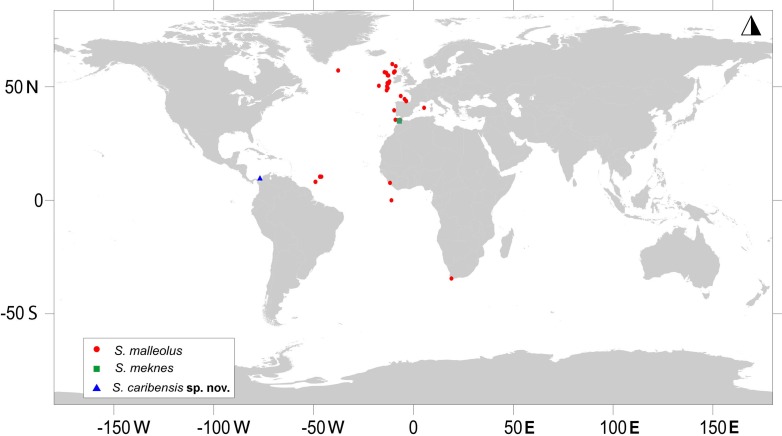
Map showing the worldwide distribution of Sphyrapus.Sphyrapus malleolus (red circles), Sphyrapus meknes (green square), Sphyrapus caribensis sp. nov. (blue triangle) [Data from: Norman & Stebbing (1886); Bonnier (1896); Lo Bianco (1903); Richardson (1905); Barnard (1920); Băcescu (1982); Holdich & Jones (1983); Băcescu (1984); Bamber (2000); Bird (2001); Błażewicz-Paszkowycz, Bamber & Cunha (2011); Natural History Museum (2014); Morales-Núñez et al. (this study)].